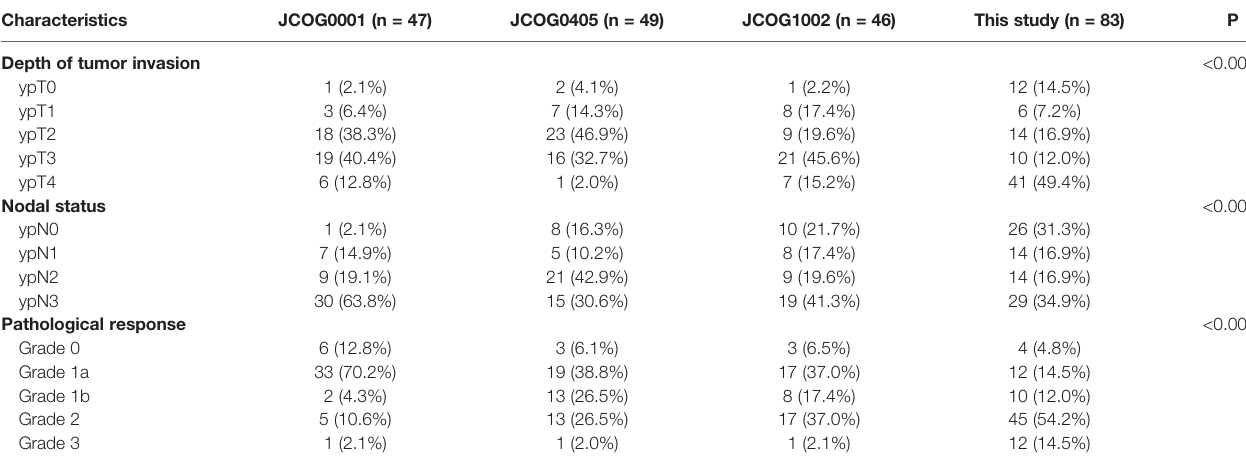
TABLE 5 | Pathological evaluation for four studies.